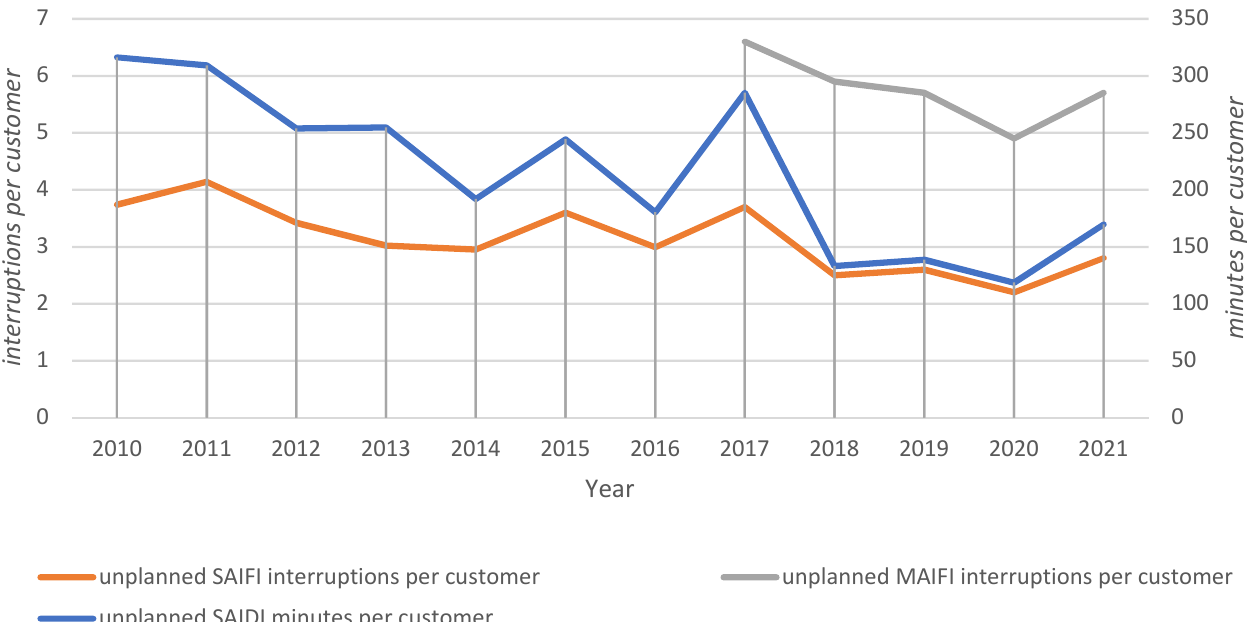
Figure 2. SAIDI, SAIFI, and MAIFI values in Poland in 2010–2021, based on [25–28]. One way of dealing with these negative consequences is the use of electricity at the place of its production, i.e., in households, for example, using electric water heaters and local energy storage.